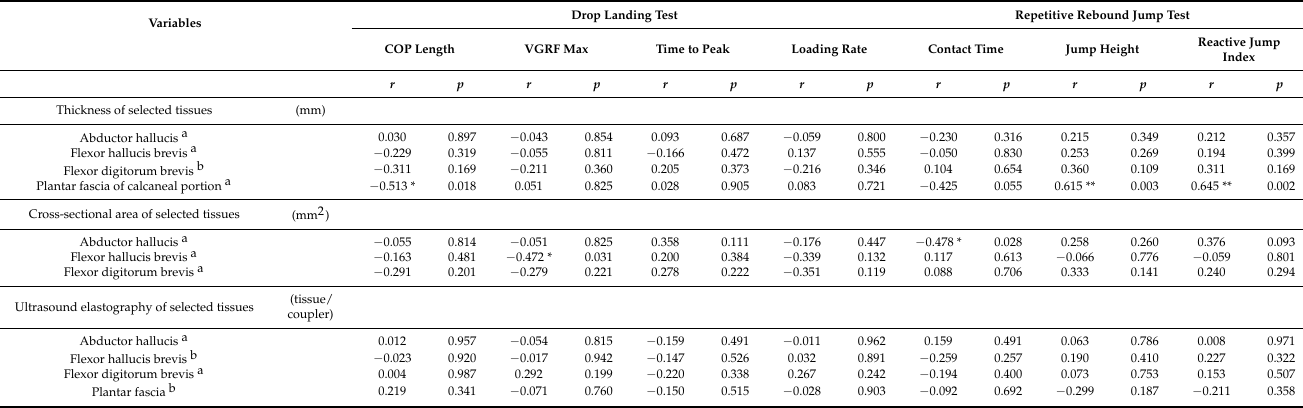
Table 2. Correlation Analysis between Ultrasonographic Measurements and Repetitive Rebound Jump and Single-Leg Drop Landing Assessment.